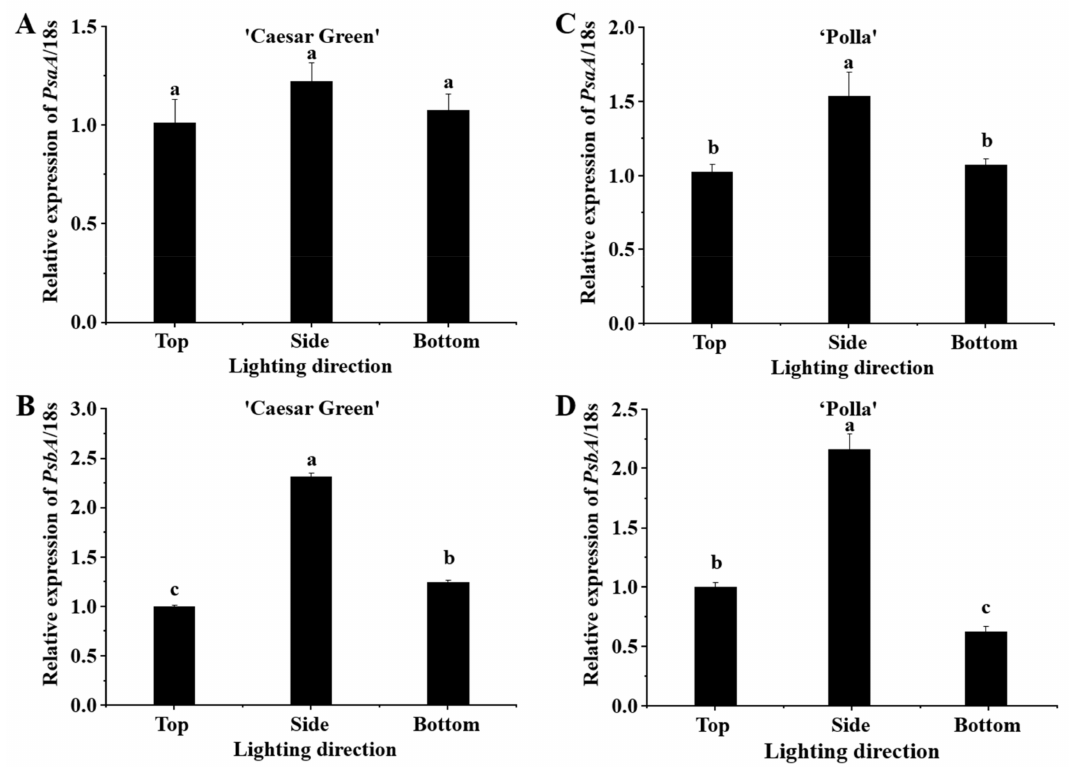
Figure 8. Relative expression levels of PsaA and PsbA in lettuce Caesar Green ( A , B ) and Polla ( C , D ). Vertical bars indicate the means ± stand error ( n = 3). Different small letters indicate the significant separation within treatments by the Duncan’s multiple range test at p ≤